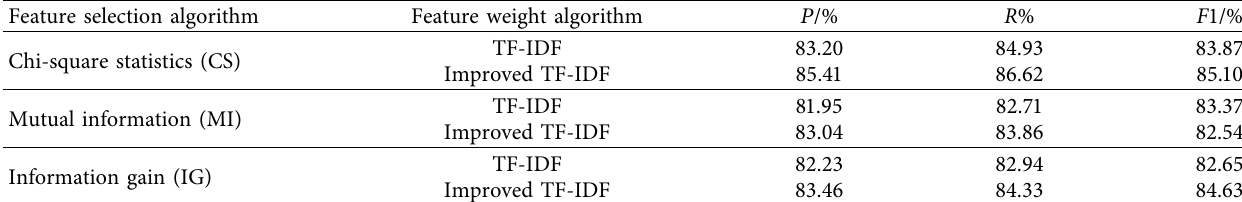
Figure 3: Comparison of P values under different feature dimensions. Table 2: Experimental results of different feature selection and feature weight